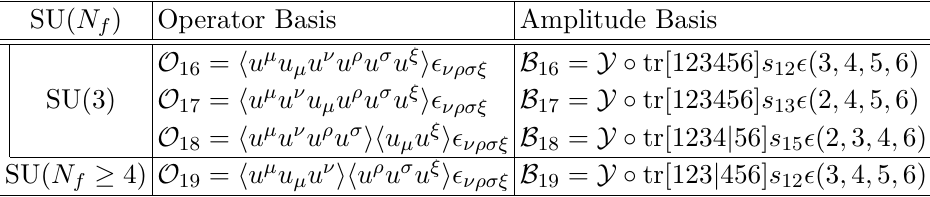
Table 10 . Independent 6-point soft basis for parity odd at order O ( p 6 ) . How the amplitude basis become linearly redundant when N decreases is explicitly shown. The corresponding operators are f also given in terms of building block u ( x ) by eq. µ